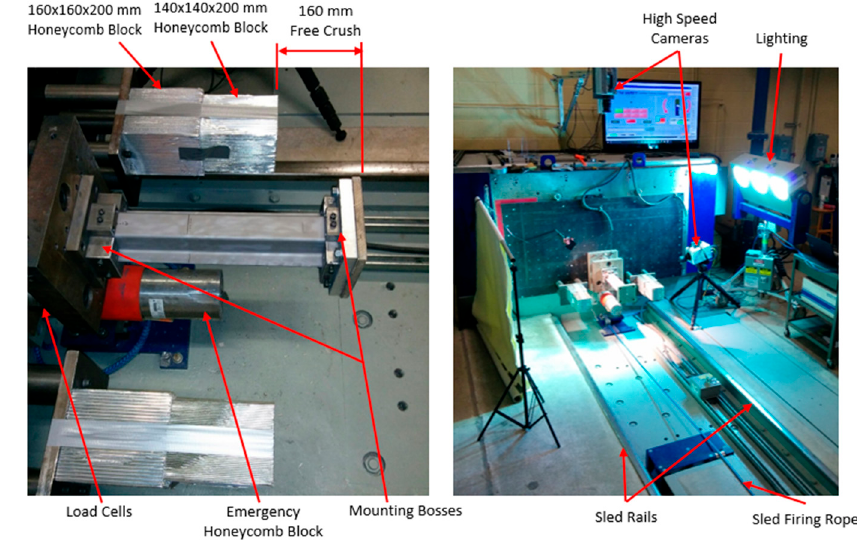
Figure 2. Dynamic axial crush test setup at UW